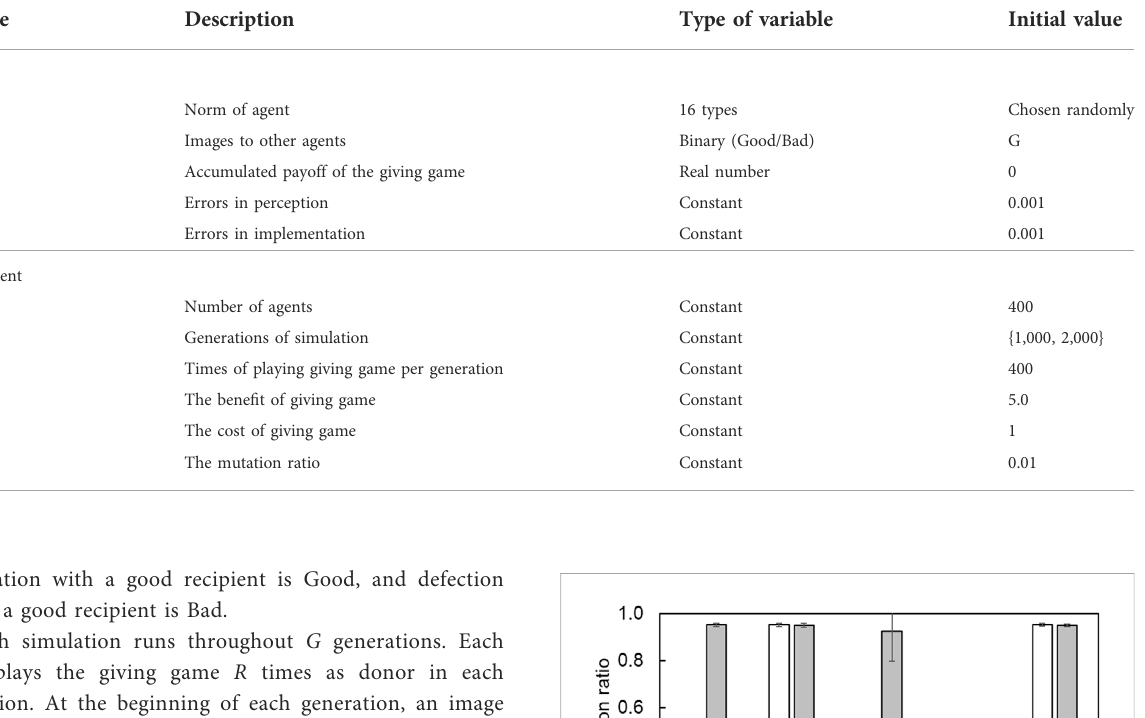
TABLE 2 State variables and initialization in the simulation.